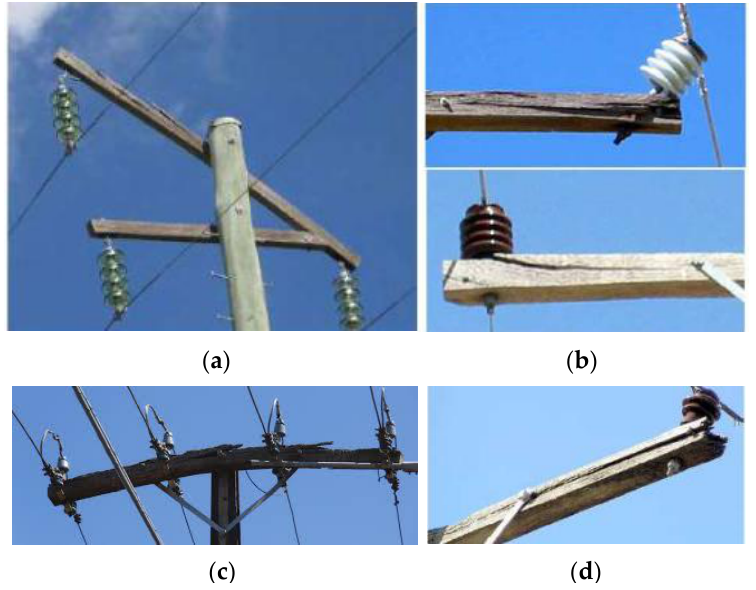
Figure 1. Deteriorated and failed timber crossarms due to decay and aeolian vibrations; ( a ) failed crossarm losing an insulator; ( b ) splitting at the end bolt locations; ( c ) badly split crossarm along the length; ( d ) losing sound wood at the end of the crossarm.